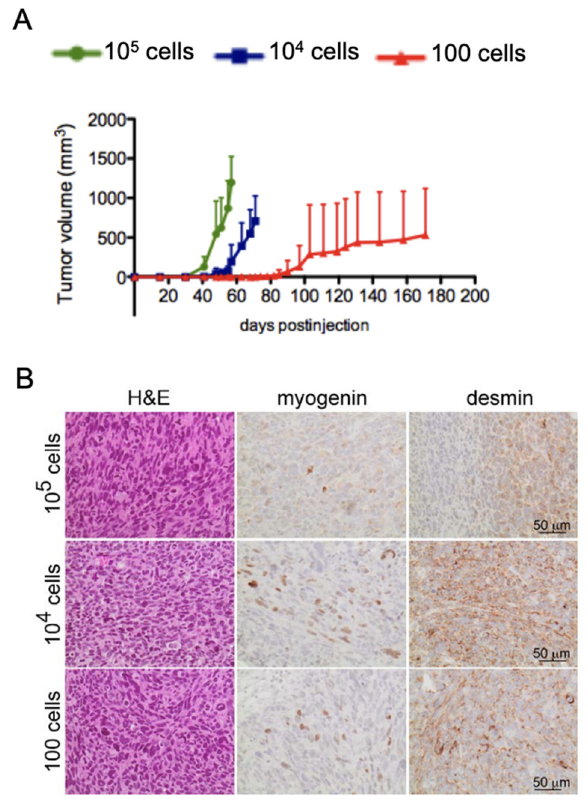
Figure 5. High frequency of tumor initiating cells in FPRMS cells. ( A ) In vivo limiting dilution with RH30 cells; 10 5 ( n = 3), 10 4 ( n = 4), and 100 cells ( n = 5) were injected intramuscularly (i.m.) into the left leg of NOD/Scid mice. Tumor growth was monitored over a period of 180 days. ( B ) Immunohistochemical analysis of xenografts generated from RH30 cells after injection of 10 5 , 10 4 , and 100 cells. Tumors were stained with H&E and the FPRMS markers MYOGENIN and DESMIN.